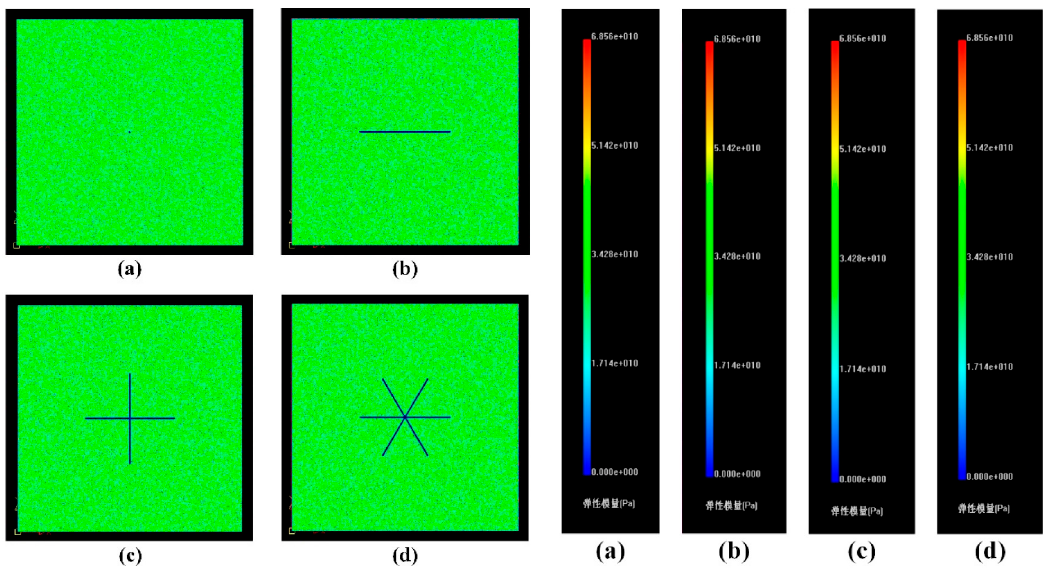
Figure 3. Four kinds of tree-type hydraulic fracturing models, left side are the models and right side are the legends; ( a – d ) they are zero-branched, two-branched, four-branched and six-branched. Table 1. Basic mechanical parameters of the hydraulic fracturing models.